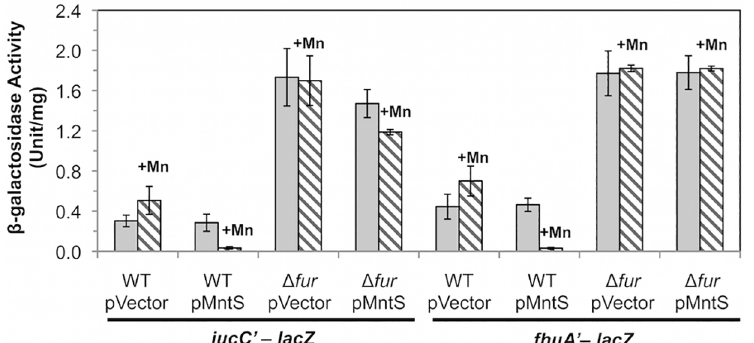
Fig 6. The Fur regulon is fully repressed upon MntS overproduction. Cells were grown in aerobic LB/ arabinose medium with or without 0.5 mM MnCl 2 and aerated for 2.5 hr before harvesting. Data represent the mean of three independent cultures. Strains bearing iucC ’ -lacZ were JEM1369 (WT/pBAD24), JEM1370 (WT/pLW112), JEM1463 ( Δ fur /pBAD24), and JEM1464 ( Δ fur /pLW112). Strains bearing fhuA ’ -lacZ were JEM1395 (WT/pBAD24), JEM1396 (WT/pLW112), JEM1465 ( Δ fur /pBAD24), and JEM1466 ( Δ fur /pLW112). The pMntS (pLW112) plasmid encodes mntS driven by the araBAD